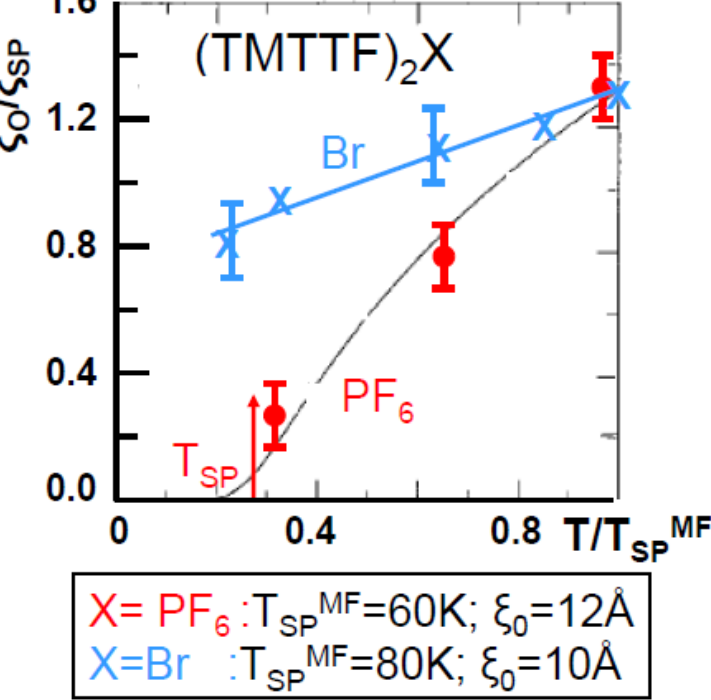
Figure 5. Thermal dependence of the inverse intra-chain correlation length ξ SP−1 of the SP instability of (TMTTF) indicated in the lower panel for each salt. The continuous line for the PF calculated [69] for the weakly localized SP